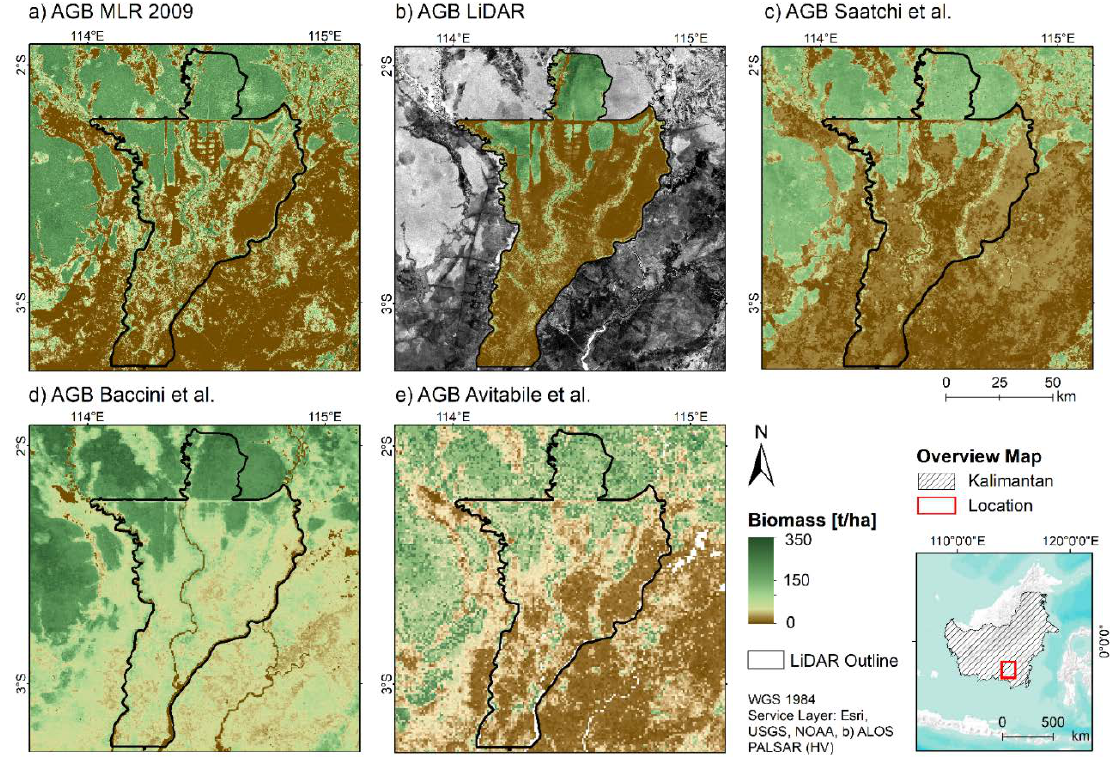
Figure 5. Comparison between different AGB maps ( a ) AGB MLR model result for 2009; ( b ) LiDAR; ( c ) Saatchi et al. (2011); ( d ) Baccini et al. (2012); and ( e ) Avitabile et al. (2016) in a range of 0–350 t/ha for a subset in the south of Kalimantan. The resolution of AGB maps of the MLR model and the LiDAR data is 100 m; the map of Saatchi et al., 1 km; the map of Baccini et al., 500 m; and the map of Avitabile et al., 1 km.